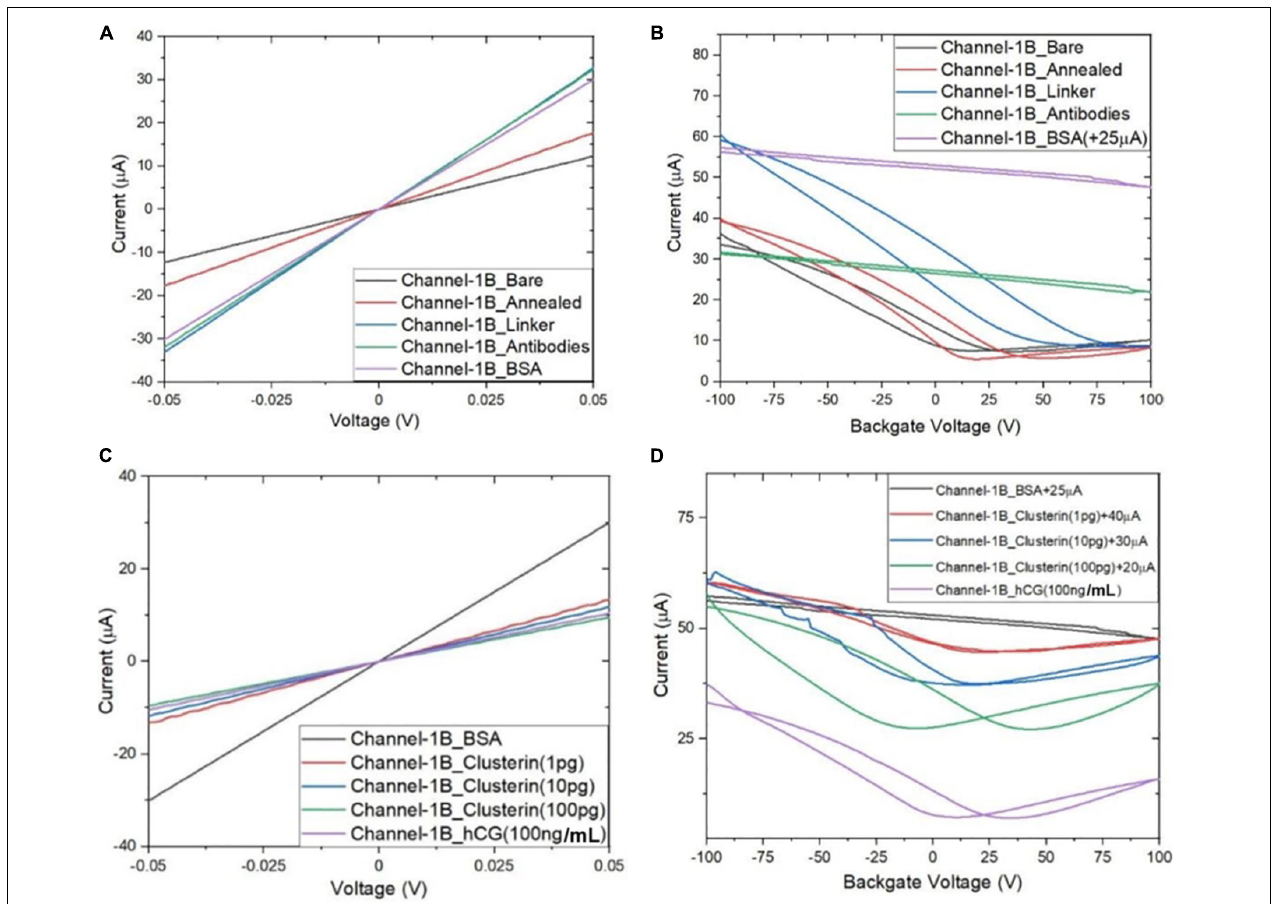
FIGURE 8 | Characteristic curves for Channel-1B (A) I D –V D output curves for bare to BSA, (B) I D –V G transfer curves for bare to BSA, (C) I D –V D curves for BSA to human chorionic gonadotropin (hCG) (100 ng), and (D) I D –V G curves for BSA to hCG (100 ng) with off-set currents shown for clarity. Antigen concentrations are in units of